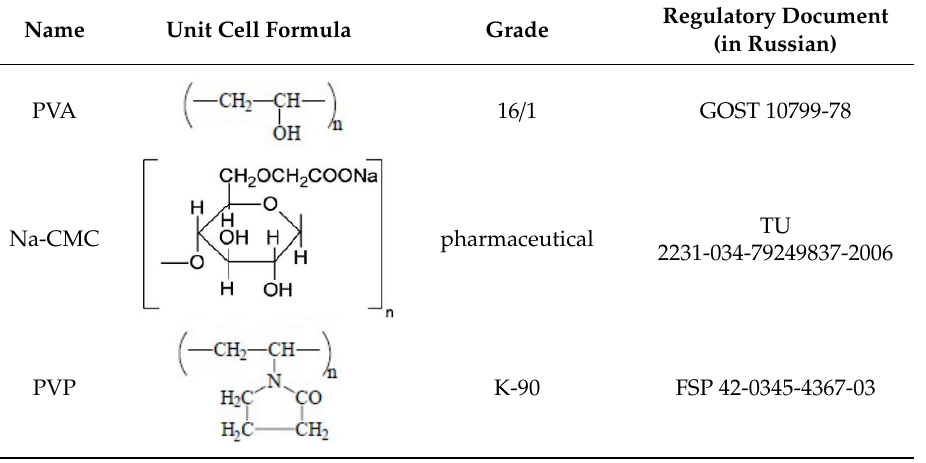
Table 2. Structural formulae and characteristics of polymers.